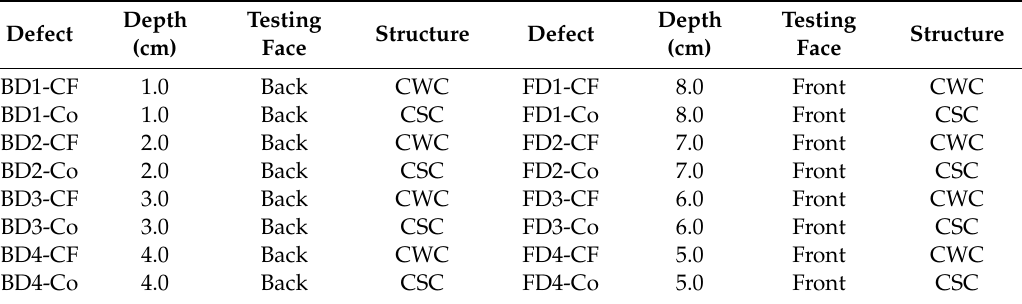
Table 1. Characteristics of